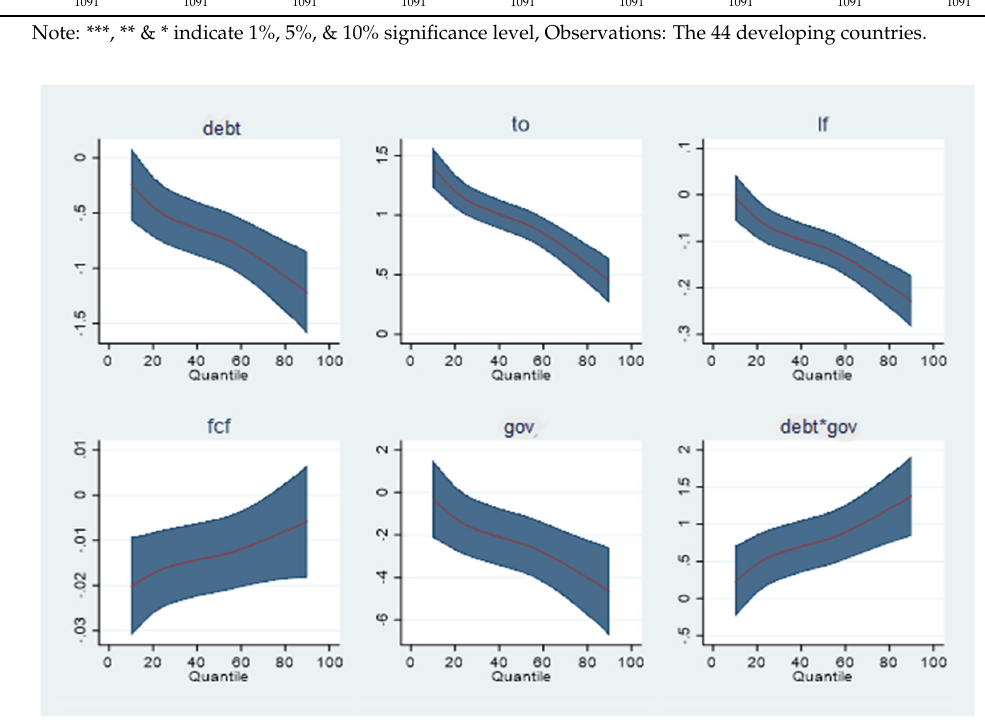
Figure 3. The moderating role of governance on the nexus between public debt and growth under different quantiles. Table 5. The moderating role governance on the nexus between public debt and growth.